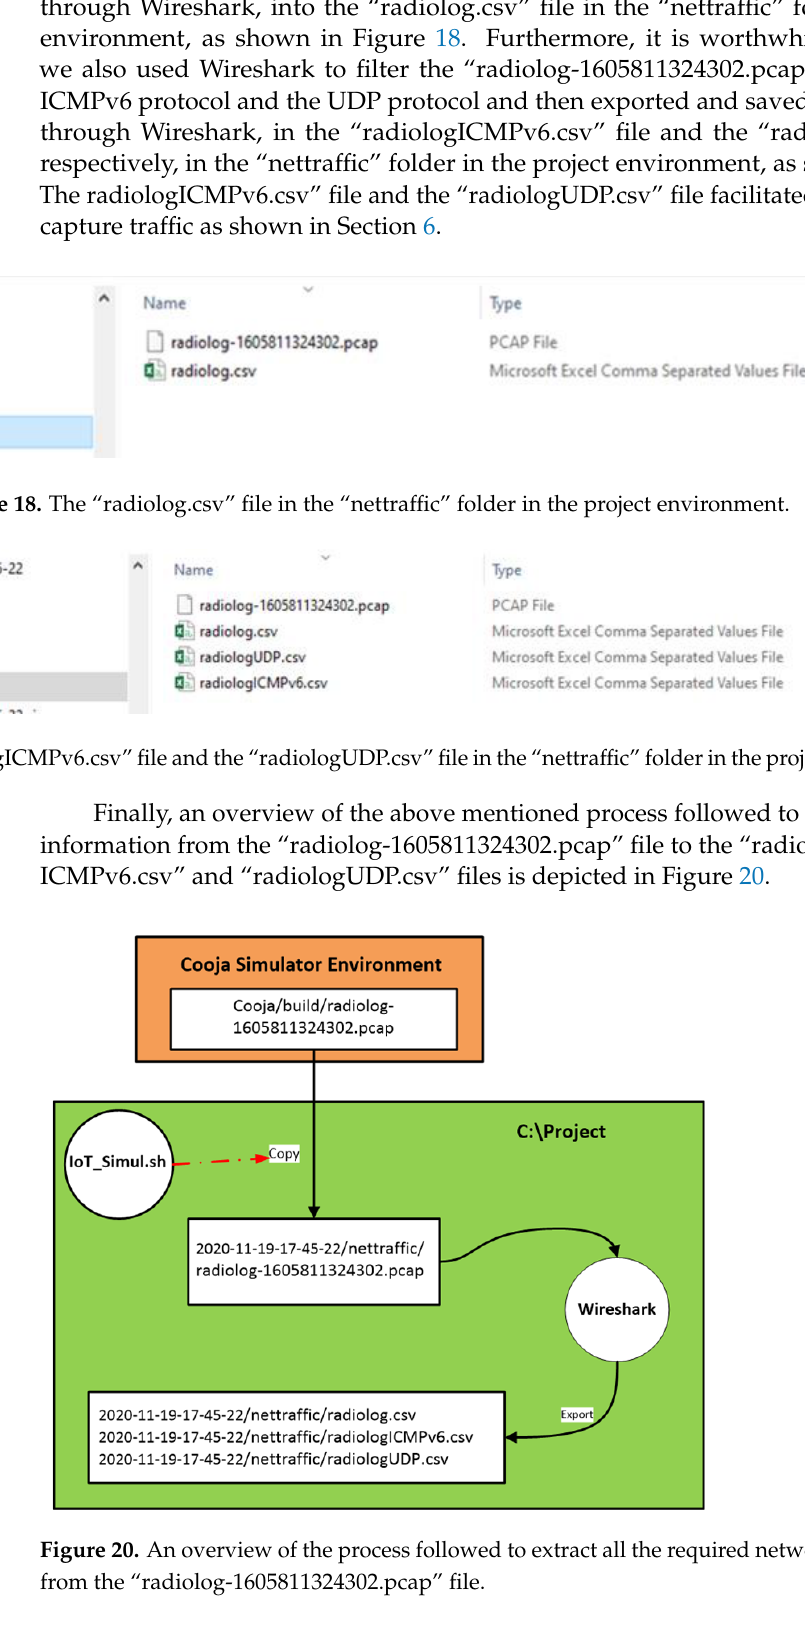
Figure 20. An overview of the process followed to extract all the required network traffic infor-